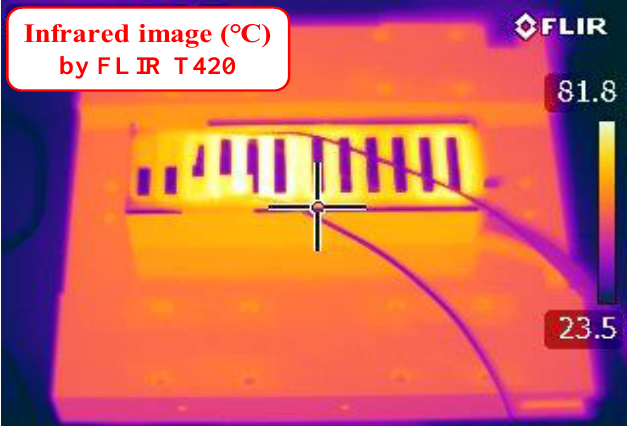
Figure 17. Measured temperature distribution under DC current loading of 2A between phases U and V.